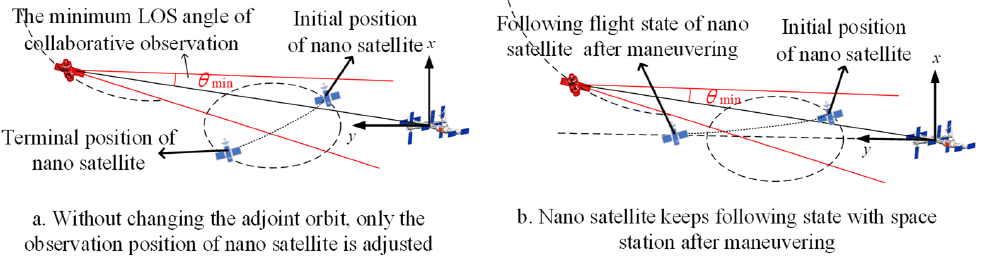
Figure 5. Scenario 2: Nano-satellite is on natural adjoint orbit at the initial time and there are some regions of the initial orbit satisfying the constraint of the minimum LOS angle.